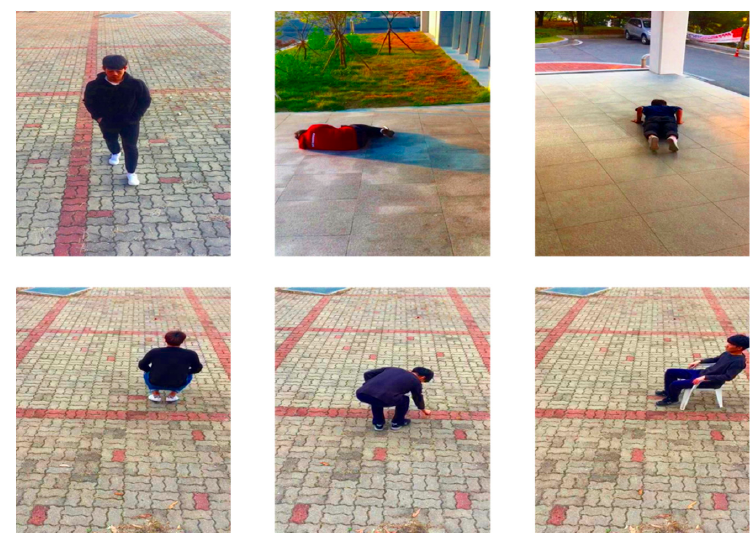
Figure 16. Representative scenes and fall cases used for the evaluation.